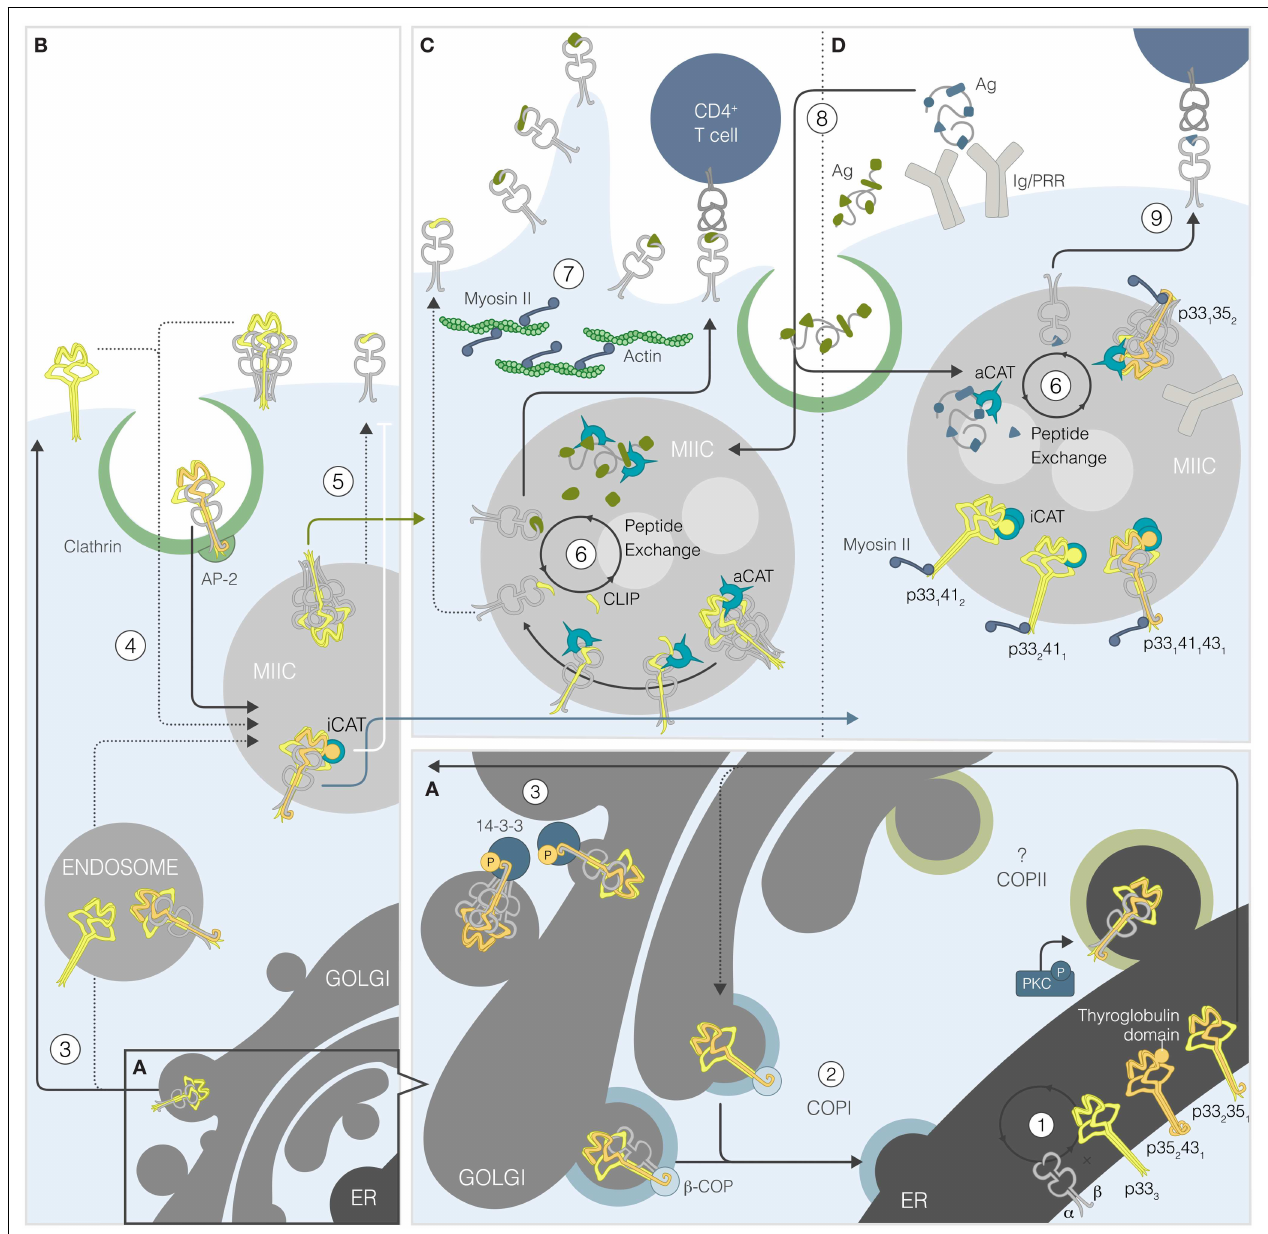
transport to the cell surface [5]. (C) In multivesicular MIICs, the carboxy-terminal trimerization domain of Ii is cleaved by non-cysteine proteases, generating the p22 fragment.Then, cysteine proteases remove the glycosylated portion to form the p10 fragment before active cathepsin S (aCAT) cuts the anchored portion, leaving CLIP in the MHCII groove. CLIP is then exchanged for an antigenic peptide spontaneously or by DM [6]. Ii degradation frees myosin II, which can restore the cell motility and remodeling of endosomes [7]. (D) Antigens are internalized by pinocytosis or receptor-mediated endocytosis and degraded by proteases, including cathepsins [8]. In the presence of p41/43, processing is more focused given the inactivation of cathepsins.Thus, the MHCIIs that gain access to the plasma membrane present peptides derived from receptor-mediated Ag internalization to CD4 + T cells